Question: In one sentence, what is this figure communicating?
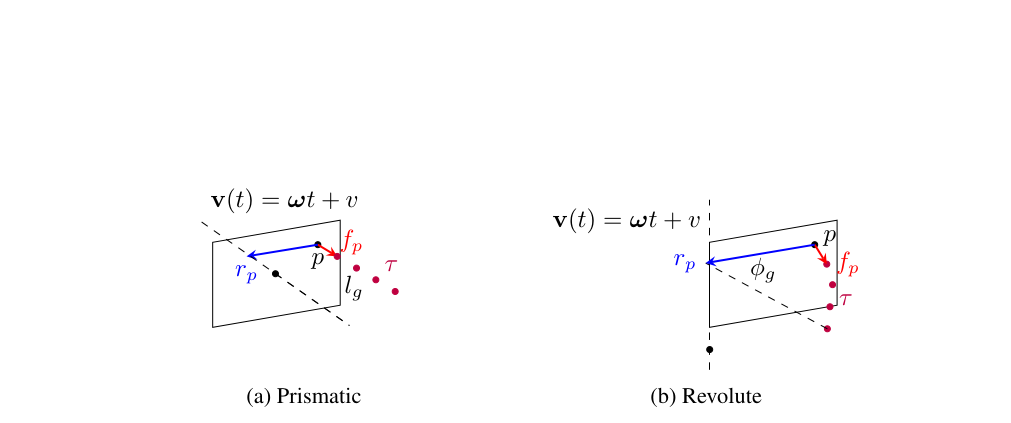
Answer: For each point p on the object, Articulation Flow fp [6] represents its instantaneous motion under a force in the opening direction; our new representation, Articulation Projection rp, represents the displacement that projects p to the articulation axis v. We train a network to predict both fp and rp and combine their predictions to get a smoother and more robust estimate. The purple points represent an interpolated prismatic trajectory of length lg and an interpolated revolute trajectory of ϕg angle rotation. This corresponds to the trajectory prediction described in Sec. 4.2.